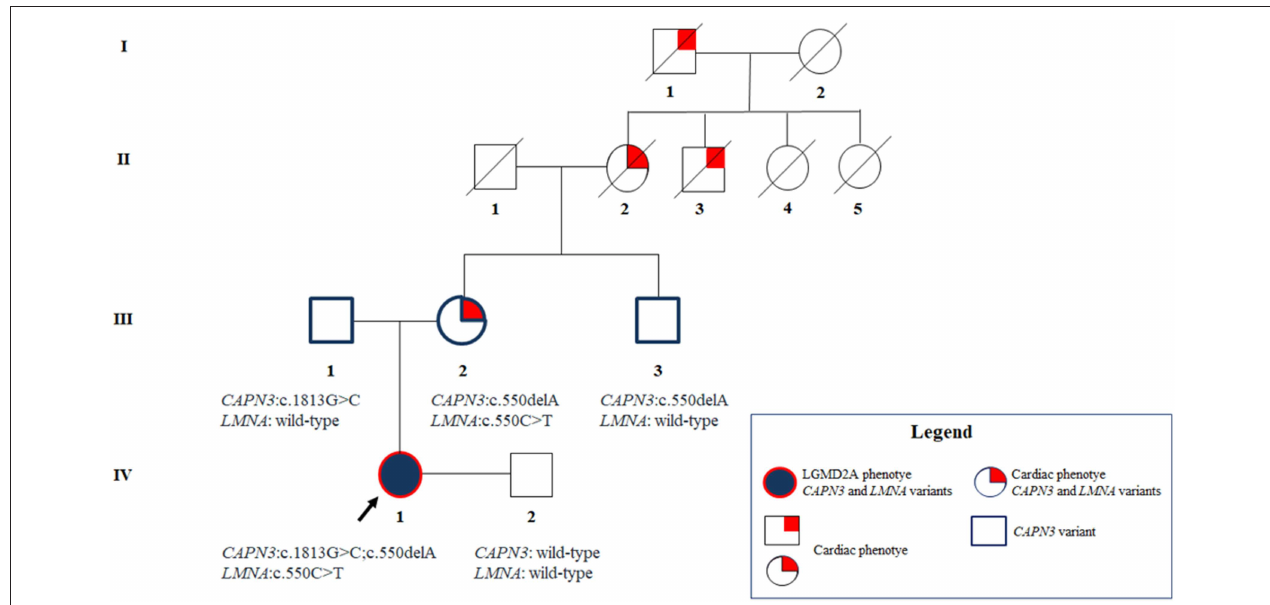
FIGURE 3 | Pedigree showing the positive familiarity for cardiac phenotype inherited by maternal lineage and the transmission of the CAPN3 and LMNA variants throughout the family members.